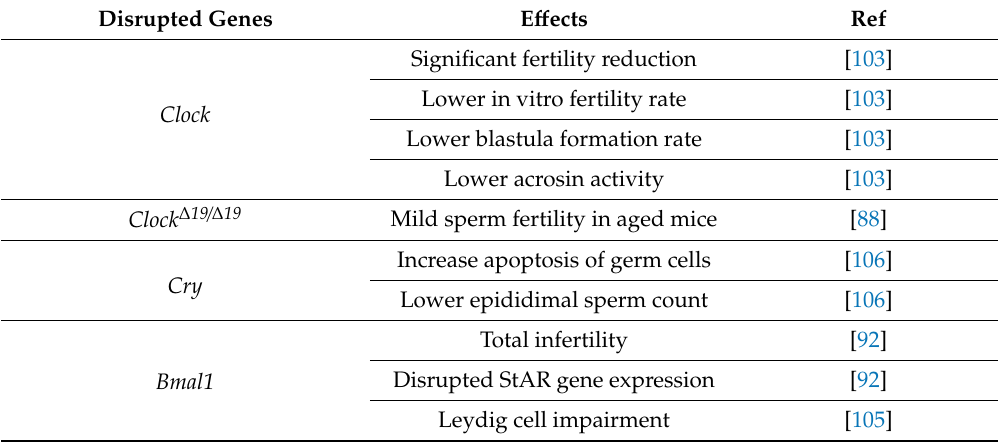
Table 3. E ff ect of disrupted genes in male mutant mice